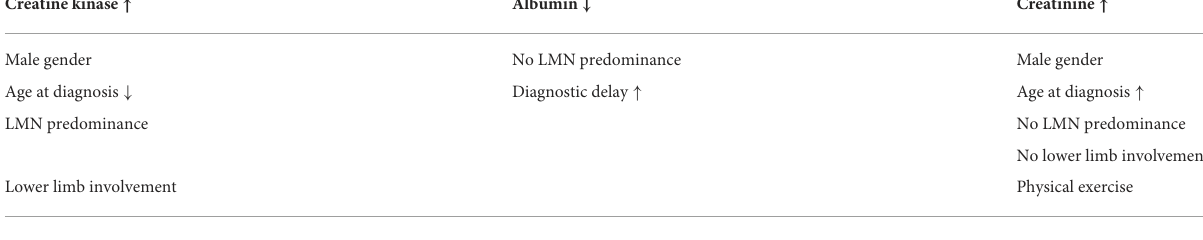
TABLE 2.2 Correlation of disease characteristics and blood